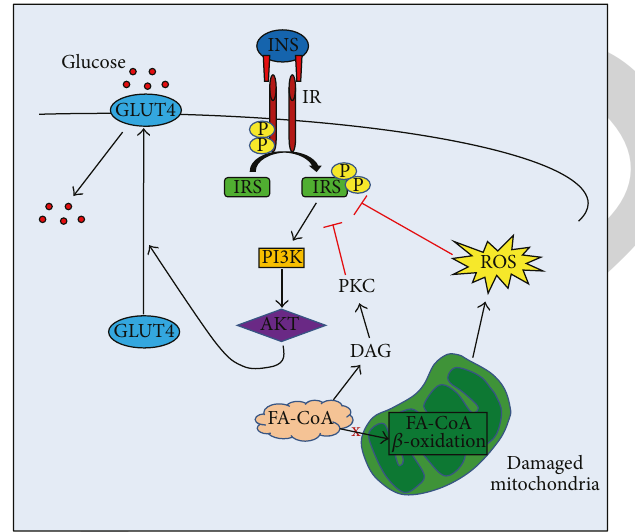
Figure 1: Mitochondrial dysfunction regulates insulin signaling. Insulin interacts with 𝛼 -subunits of its receptor (IR) on cell membrane. In response to stimuli, tyrosine residues undergo autophosphorylation, and the IR phosphorylates the insulin- receptor substrate-1 (IRS-1) in serine residues, activating Akt, with phosphorylation of the type 4 glucose transporter (GLUT4) to the cell membrane and facilitation of glucose uptake. Mitochondrial dysfunction inhibits insulin signaling, leading to insulin resistance, by (1) interfering with oxidation of fatty acyl-CoA and consequent accumulation of diacylglycerol, with consequent activation of pro- tein kinase C and phosphorylation of IRS-1 in tyrosine residues preventing its activation, and (2) through the generation of ROS, which inhibits IRS phosphorylation in serine